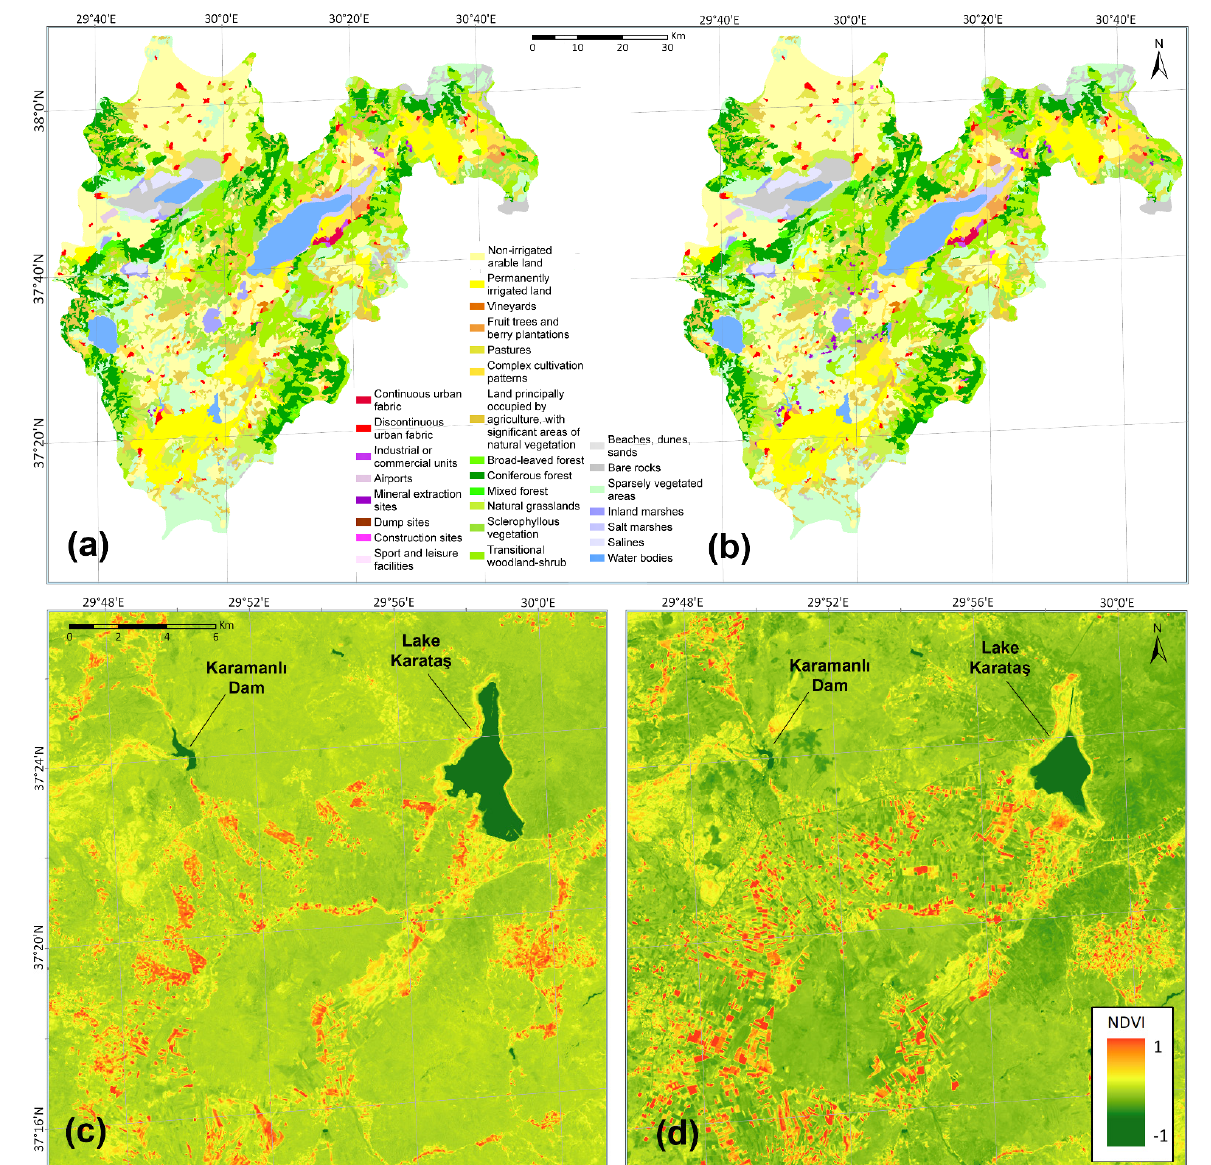
Figure 3. CORINE land-use map (( a , b ), years 2006 and 2018, respectively) (red: irrigated areas; dark green: forest; light green: natural grassland and pasture; yellow: agricultural land without irrigation; purple: mineral extraction sites; gray: urban and salt marshes) and Landsat NDVI images (red: healthy vegetation) from 6 September 2006 to 23 September 2018 (( c , d ), respectively) for the Lake Karata ş region in c and d, respectively.